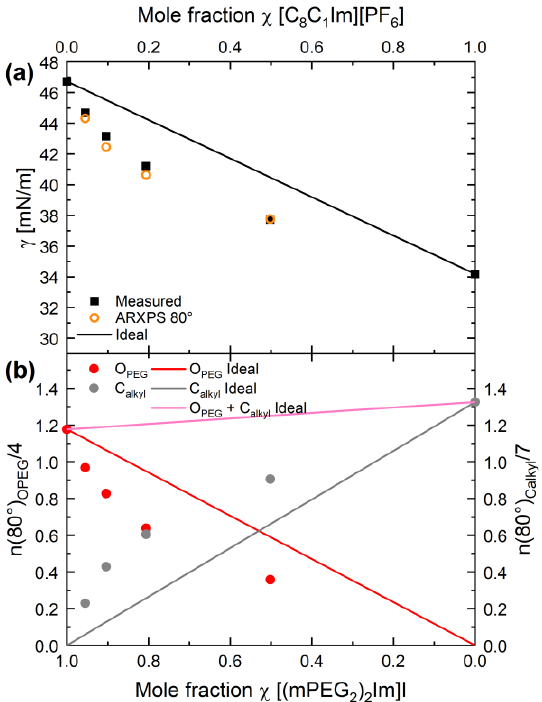
Figure 6. ( a ) Surface tension values of the pure ILs and the mixtures at 298 K (black squares), as determined from pendant drop measurements in Figure 5, along with the surface tension values calculated from the 80° ARXPS data according to Equation (3) (open orange circles) as a function of bulk mole fraction. For comparison, the surface tension of ideal mixtures without enrichment/de- pletion effects is shown as the black line. ( b ) Number of atoms, n(80°), as determined from the ARXPS data at 80°, normalised to the number of corresponding atoms in the IL for O PEG (red circles) and for C alkyl (grey circles) for the pure ILs and for the mixtures at T = 298 K. Straight lines show ideal behaviour, that is, expected changes without surface enrichment/depletion effects being pre- sent.